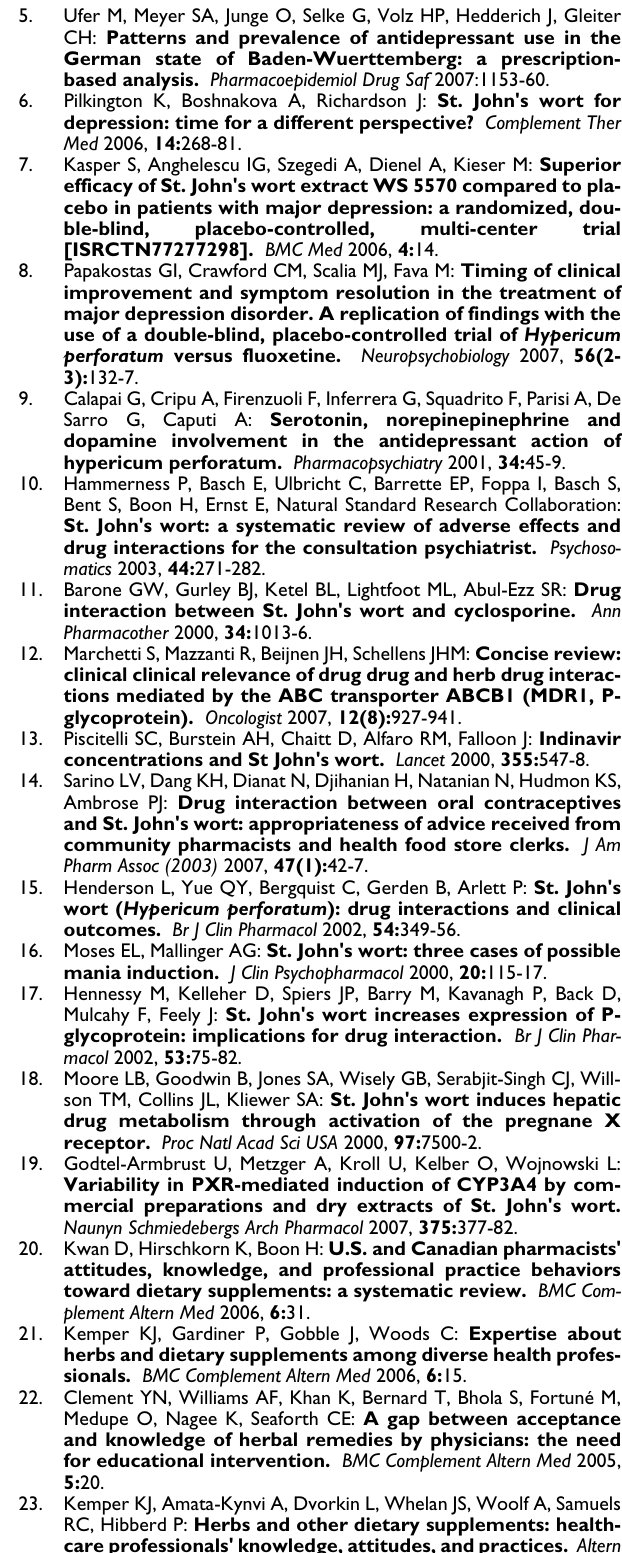
Table 1. SJW label data for categories of safety issues. Click here for file [http://www.biomedcentral.com/content/supplementary/1472-